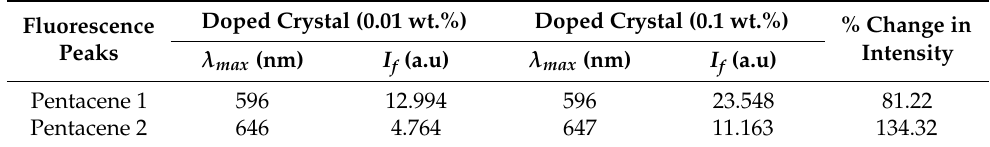
Table 4. Fluorescence characteristic peaks representing pentacene in pentacene-doped p-terphenyl crystals.